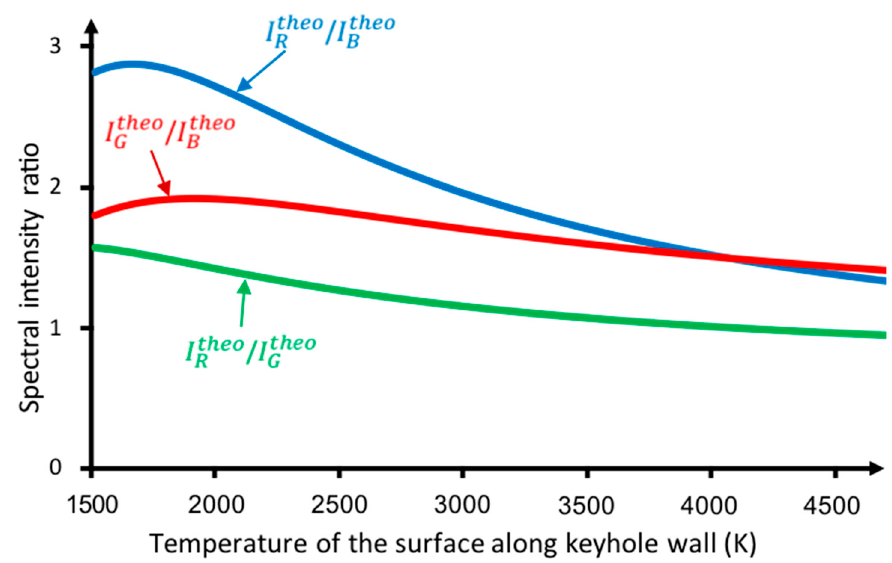
Figure 7. Relationship between theoretical radiation intensity ratios to temperature on the surface along the keyhole wall.